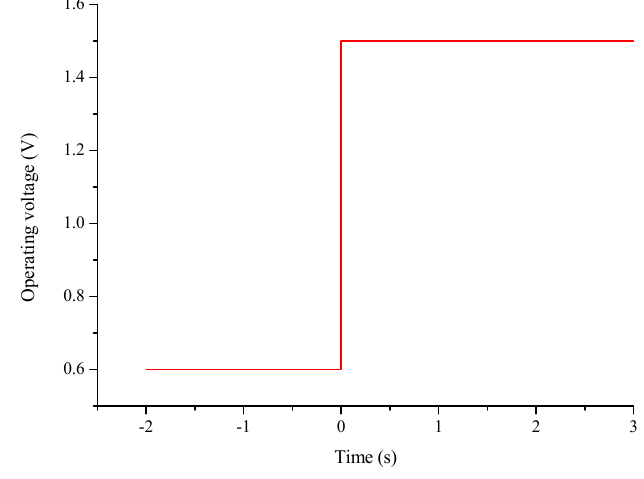
Figure 5. Transient response of the operating voltage to time under mode switching. Table 2. Physical parameters and basic conditions.